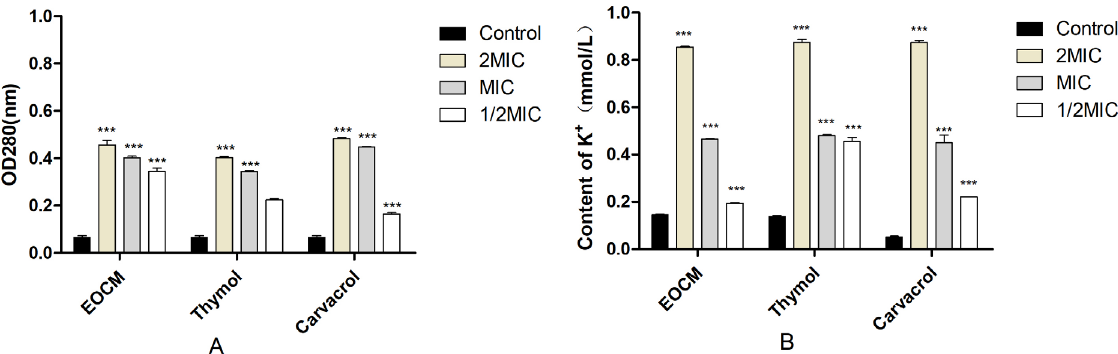
Figure 3. ( A ) is the release of nucleic acids from S. aureus treatment with EOCM, thymol and car- vacrol. ( B ) is the content of K + from S. aureus treatment with EOCM, thymol and carvacrol. Error bars represent the standard deviations (SD) of the means from three biological replicates ( n = 3) in an individual experiment. ***, results were significantly different from those of control by a t test ( p < 0.001).